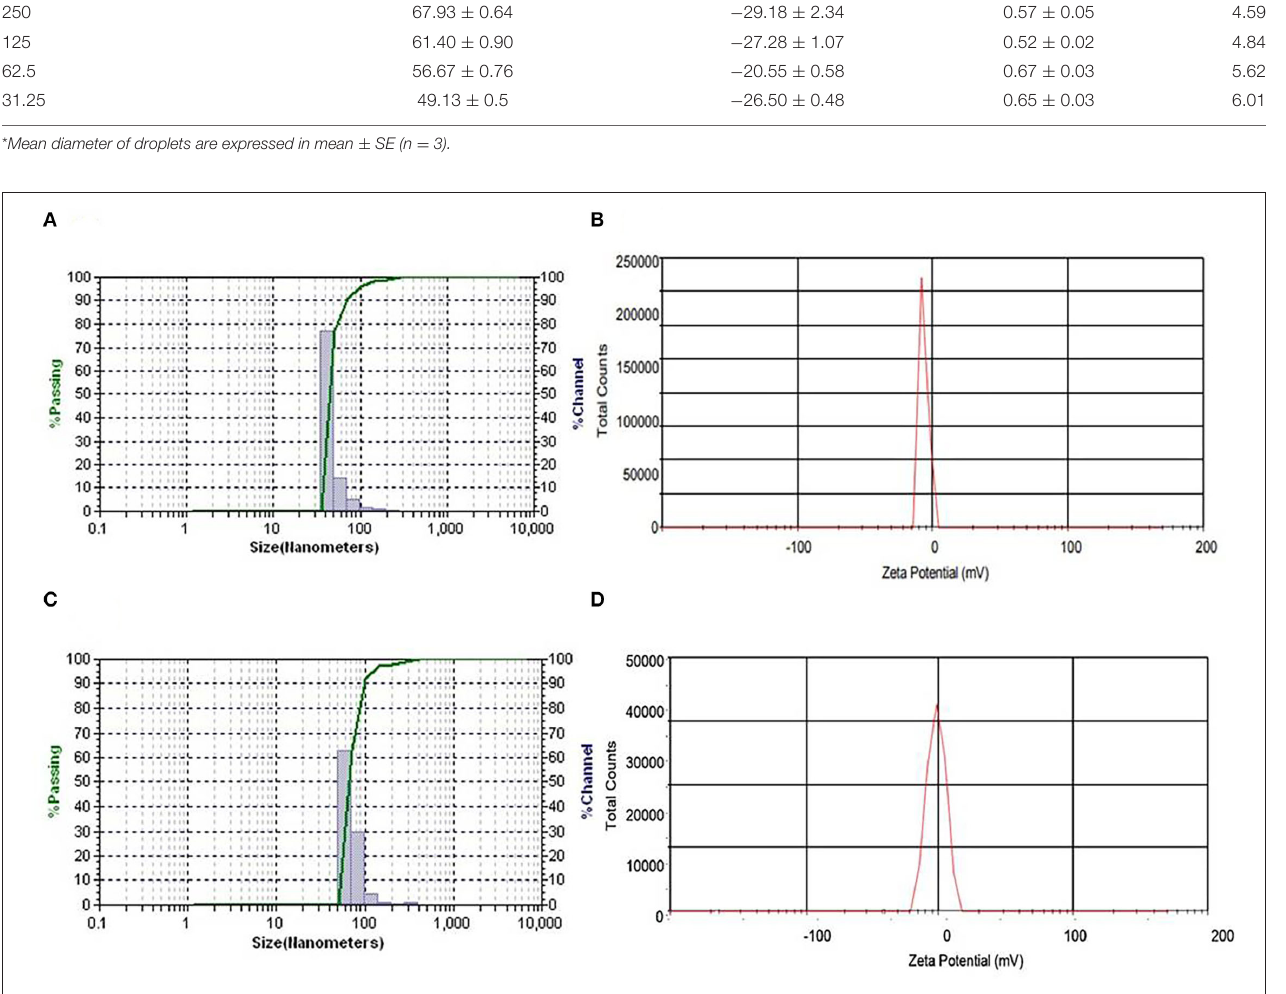
FIGURE 4 | (A) Particle size distribution and (B) zeta potential of 500 µ g mL − 1 concentration of NEs of EO. (C) Particle size distribution and (D) zeta potential of 500 µ g mL − 1 concentration of NEs of HE.